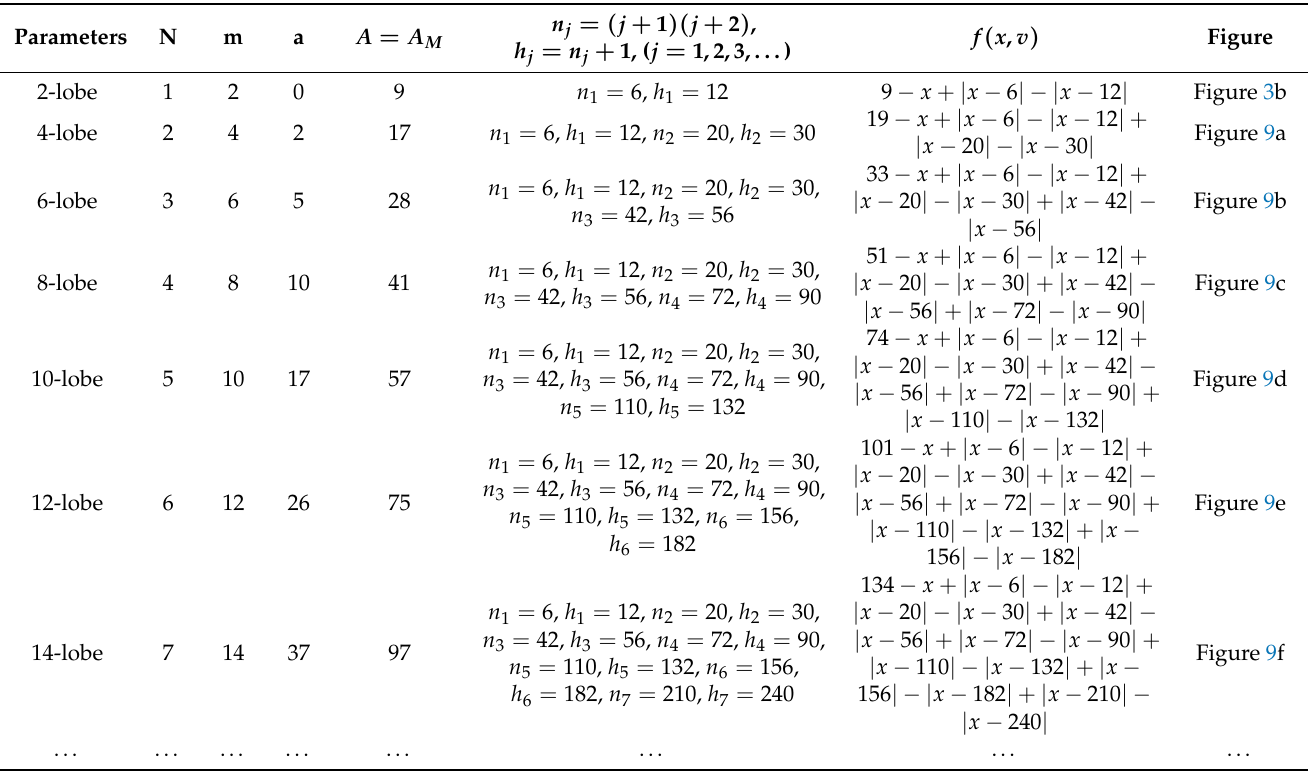
Table 1. The relationship between parameters and the number of the lobes for the m -lobe